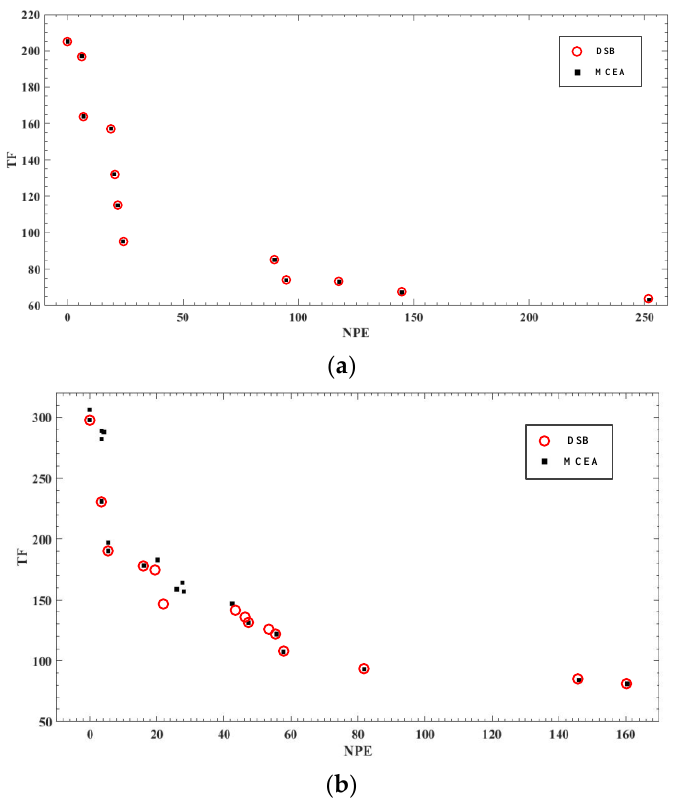
Figure 5. The results of DSB and MCEA, ( a ) in 4 jobs × 5 machines, ( b ) in 5 jobs × 5 machines.